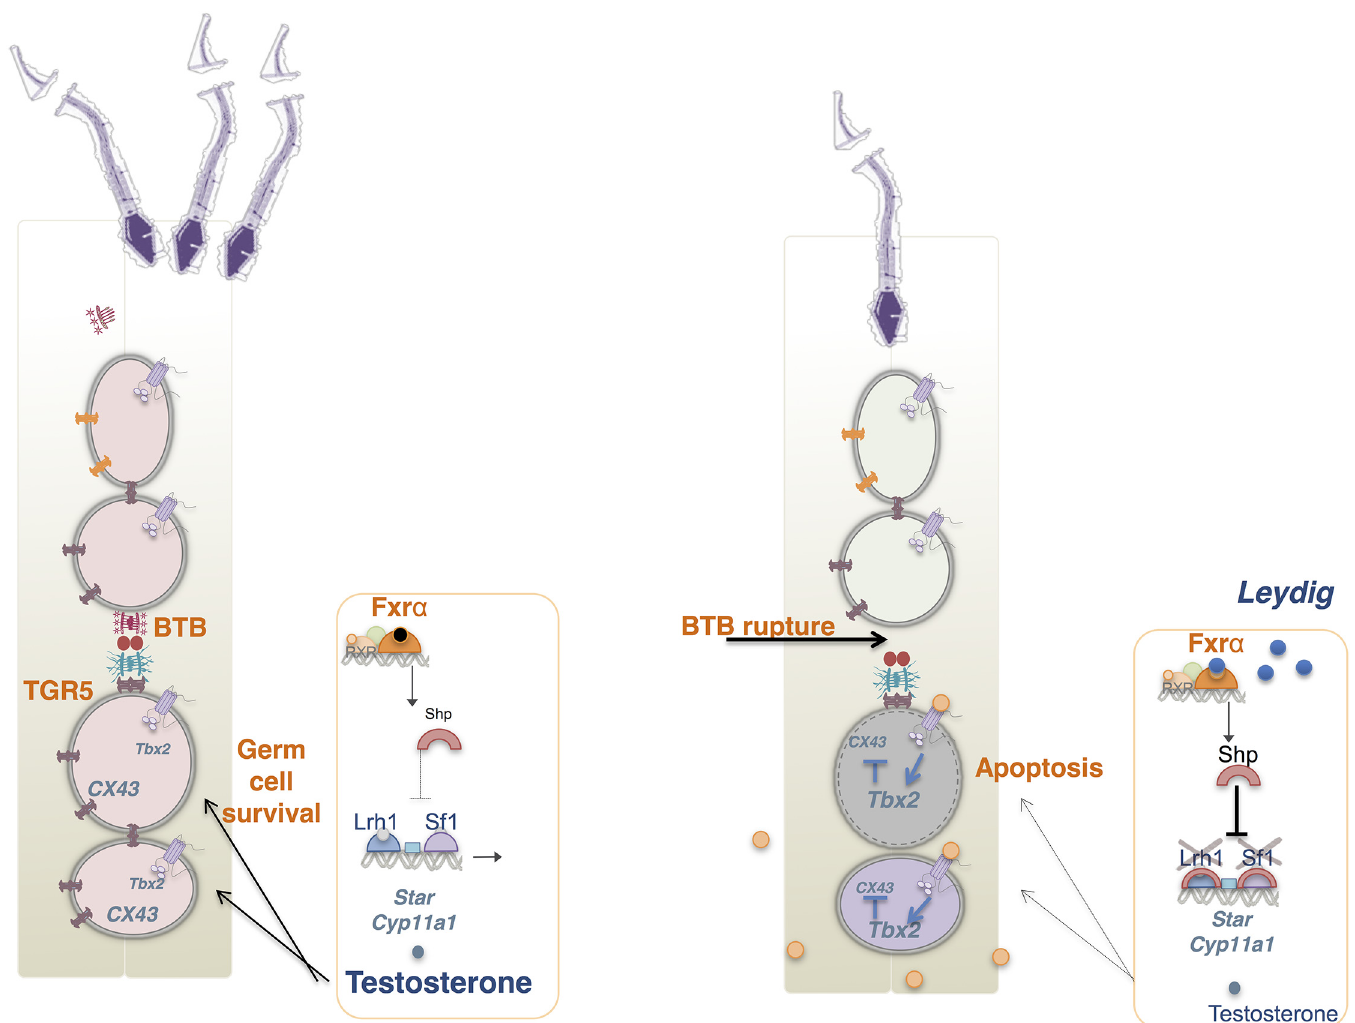
Fig 6. Potential intratesticular action of BAs. In normal condition production of testosterone is involved in germ cell survival. The expression of genes involved in steroidogenic pathway is in part supported by transcriptional activity of LRH – 1 and SF1. In parallel, the integrity of the seminiferous epithelium is ensured by the establishment of cell-cell interactions involving protein such as Cx43. In the context of BA exposure, lower production of testosterone is observed. This is consistent with the potential activation of the FXR α which in turn leads to activation of SHP a known repressor of steroidogenic pathways via the inhibition of transcriptional activity of LRH – 1 and SF – 1 on promoter sequences of genes such as Star or Cyp11a1. In parallel, in BA context, the integrity of blood testis barrier is altered. This is consistent with the activation of the TGR5-Tbx2 signaling pathways leading to lower accumulation of protein involved in cell-cell interactions that destabilized the structure of the seminiferous epithelium. These alterations might participate to the increase rate of germ cell apoptosis within the testis. In regards to the major role of testicular physiology, even though post-testicular impact cannot be exclude; the present work suggests that this alterations of testicular physiology induced in a HF-diet context might participate to the appearance of male